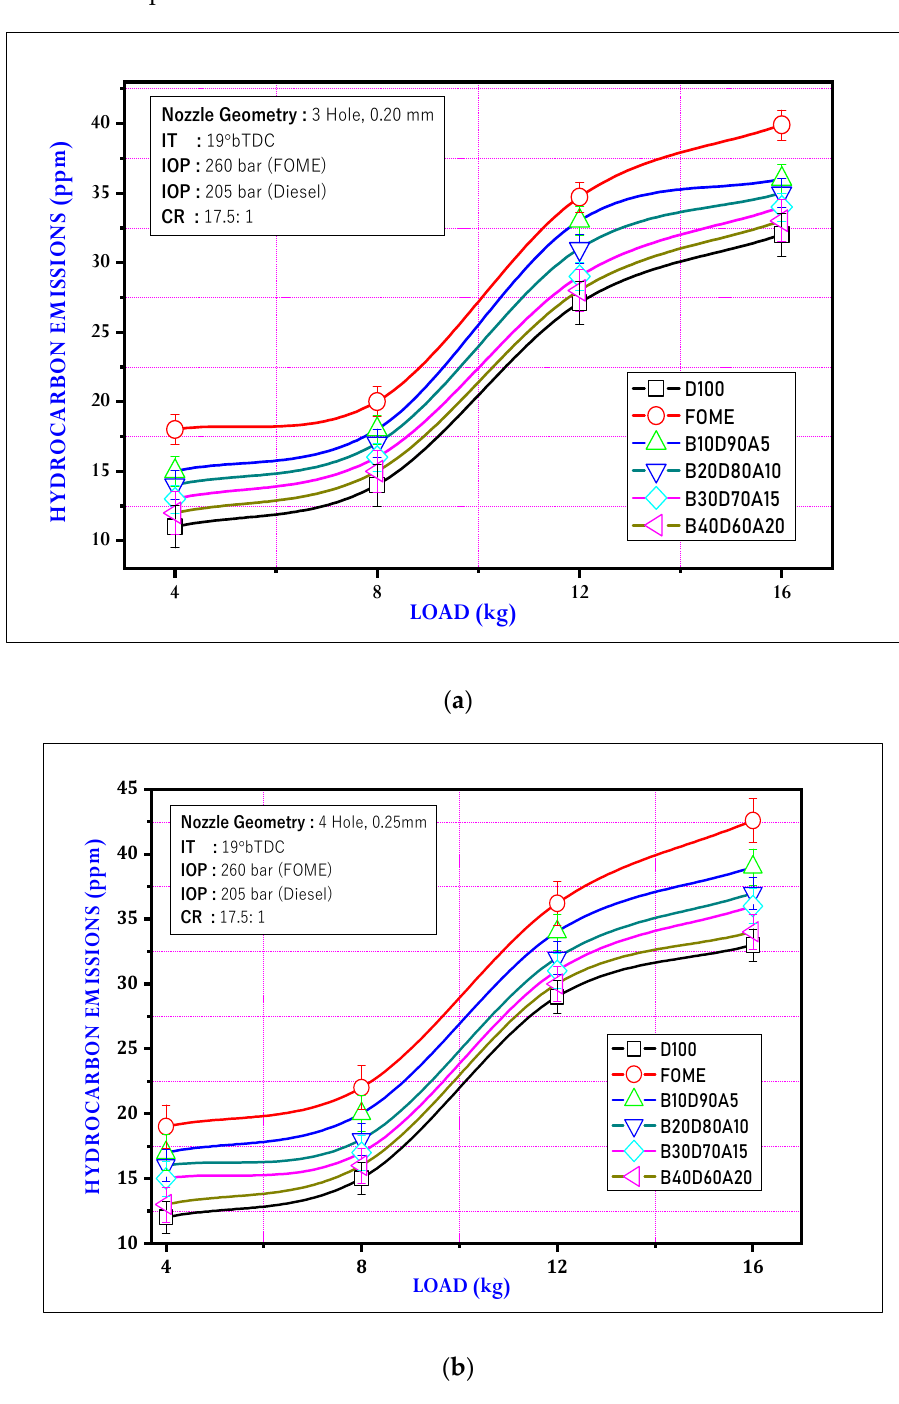
Figure 10. ( a ) Variation in HC emission with load for the 3-hole fuel injector. ( b ) Variation in HC emission with load for the 4-hole fuel injector.